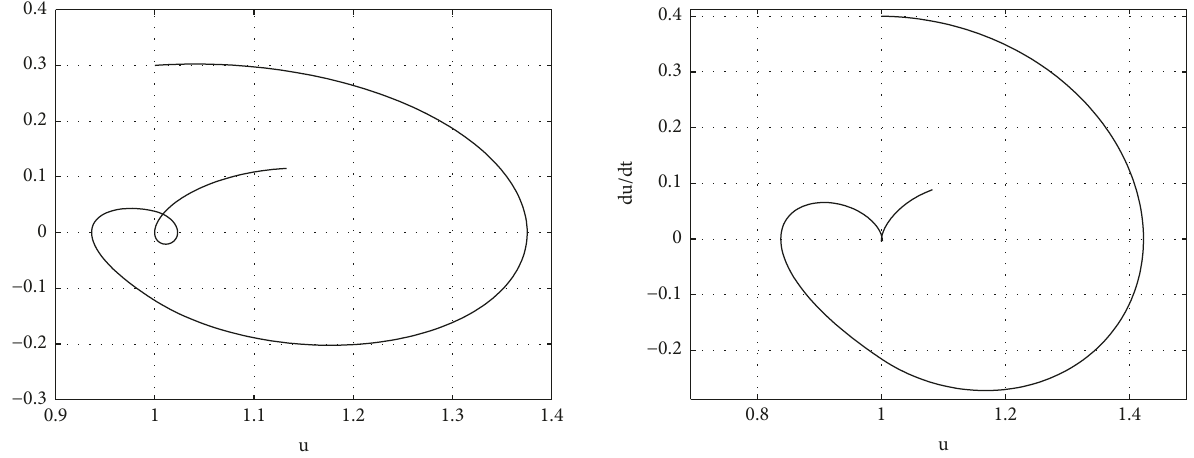
Figure 7: Grazing trajectories at (1,0).